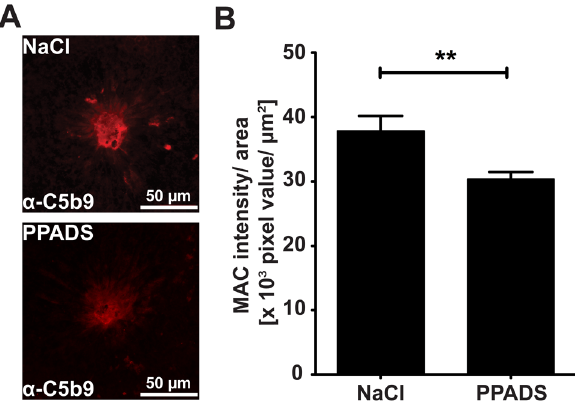
Figure 5. PPADS Inhibits Deposition of MAC at the site of laser induced CNV . A ) Representative images of C5b9 labeling at 7 days post laser in eyes treated with 0.9% NaCl or 4.17 mM PPADS topically for 3 days. B ) Mean values 6 SEM of C5b9 intensity/area of 0.9% NaCl treated eyes and 4.17 mM PPADS treated eyes 7 days post lasering. Studies were performed 3 times with 5 mice in each group, n=15, NaCl=91 laser spots, PPADS=71 laser spots (** p , 0.005).